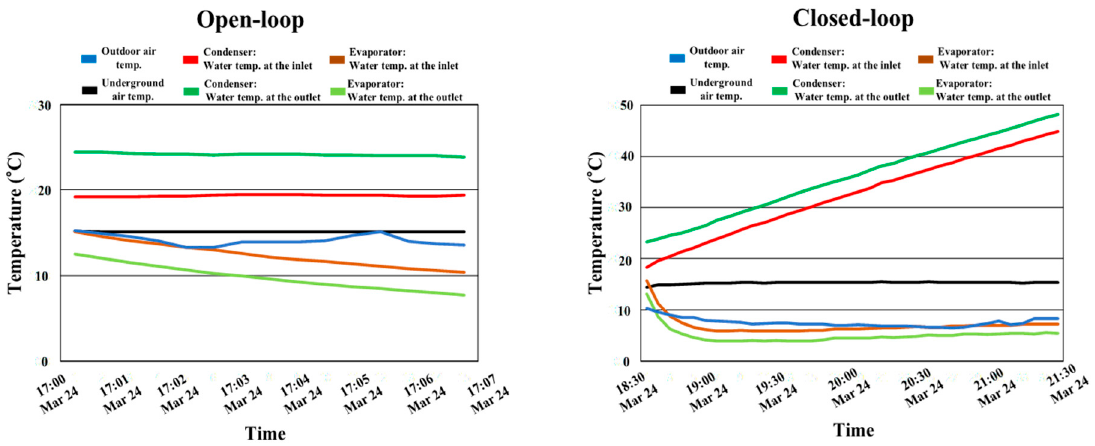
Figure 2. Temperature profiles of the system for open-loop and closed-loop application.